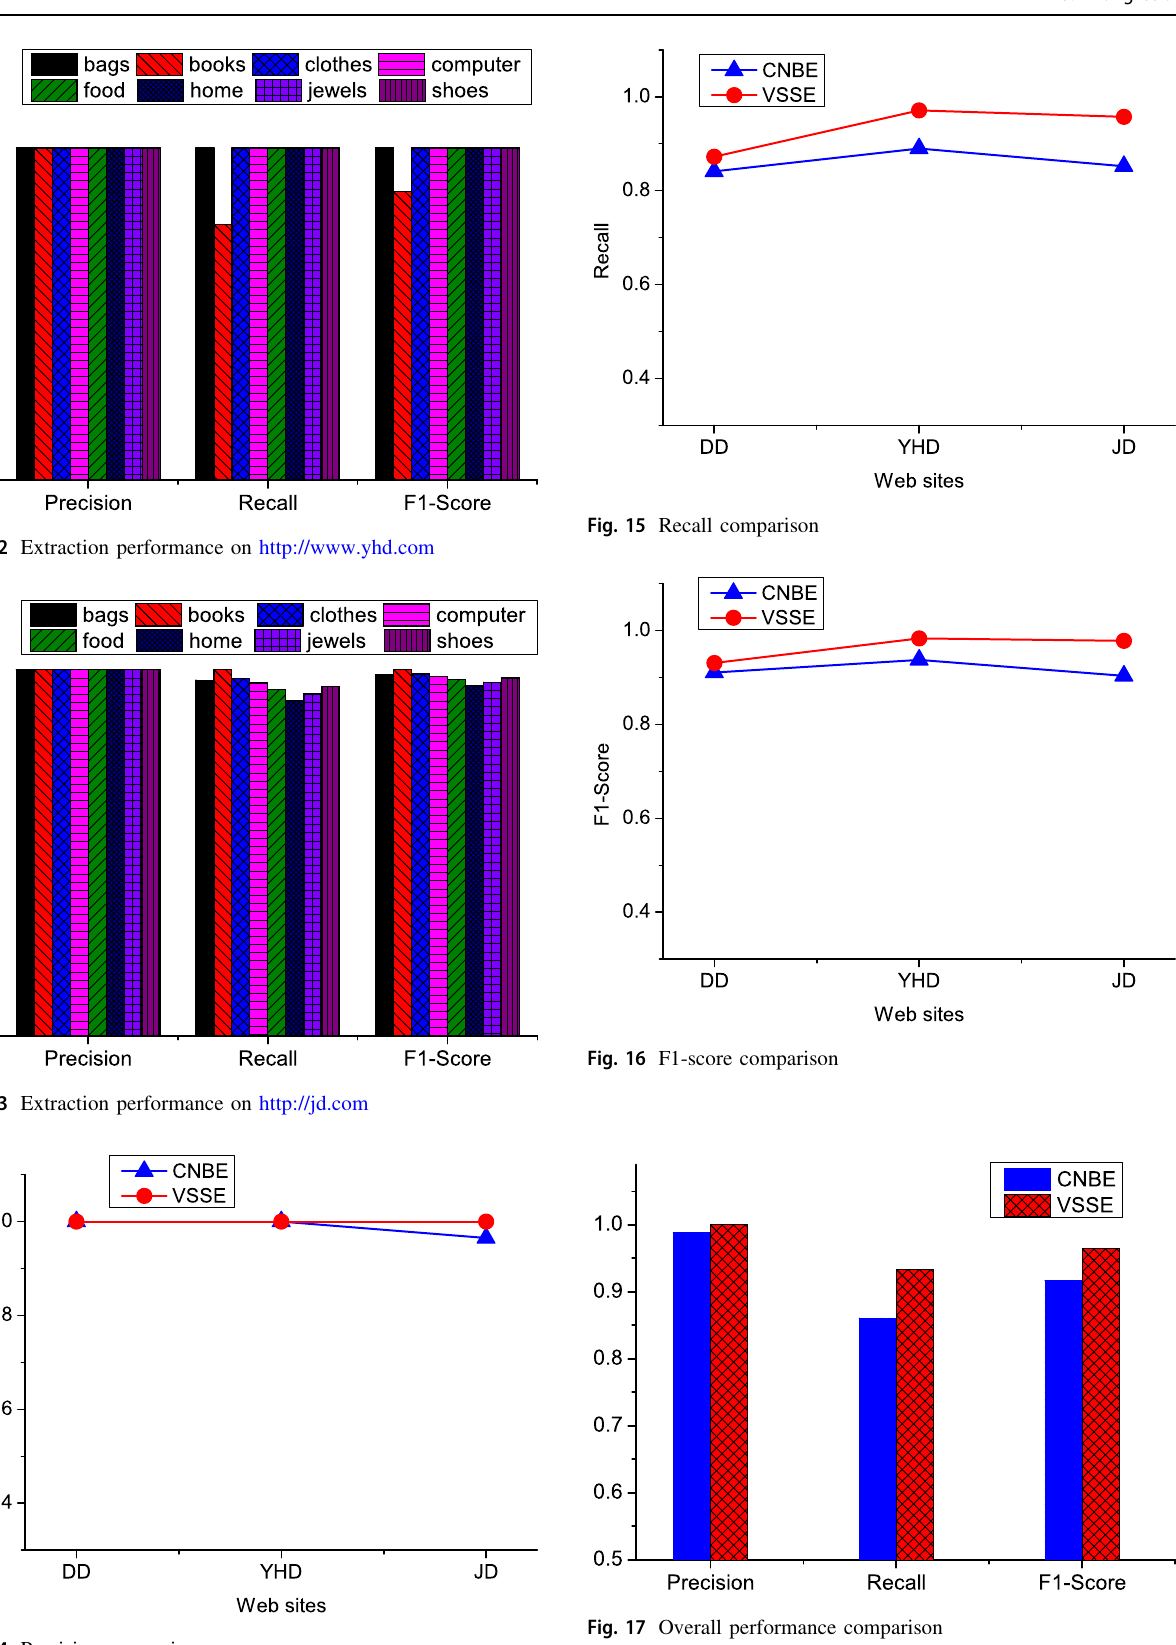
Fig. 14 Precision comparison